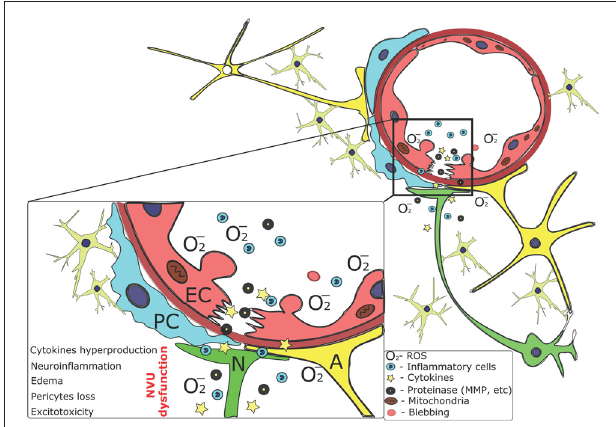
FIGURE 3 | Senescence-associated changes contribute to BBB/NVU impairment in aging. BMECs and perivascular cells serve as a source of cytokines, reactive oxygen species (ROS) and proteases affecting BBB permeability, energy production and metabolism in the barrier cells as well as excitability and synaptic plasticity of neighboring neurons. These events lead to progressive loss of barrier properties, metabolic alterations in affected cells (i.e., ATP and nicotinamide adenine dinucleotide (NAD + ) depletion), initiation and progression of apoptosis or autophagy, and development of neuroinflammation. As a result, vicious circle is established leading to further changes in BBB structural and functional